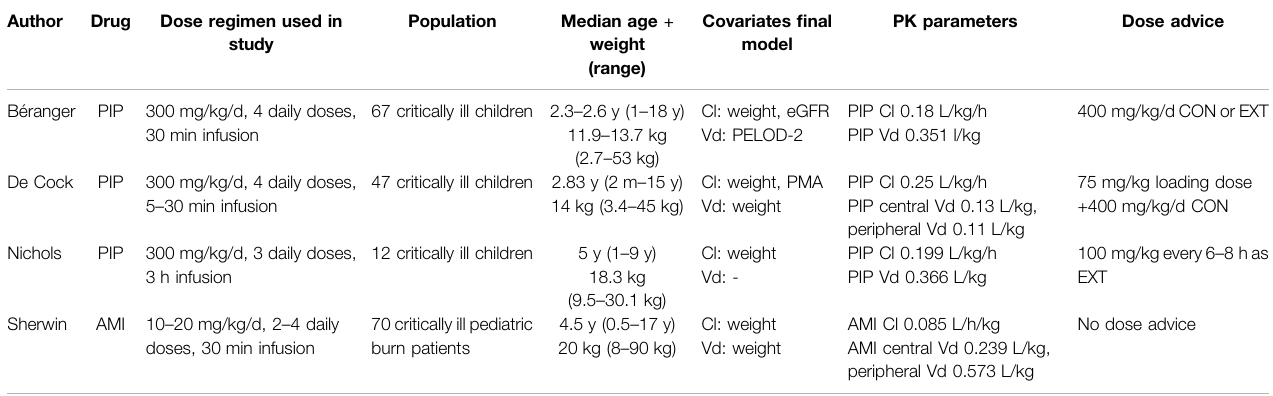
TABLE 1 | Overview of study characteristics, populations, PK parameters and dose advice in the used pop-PK models.